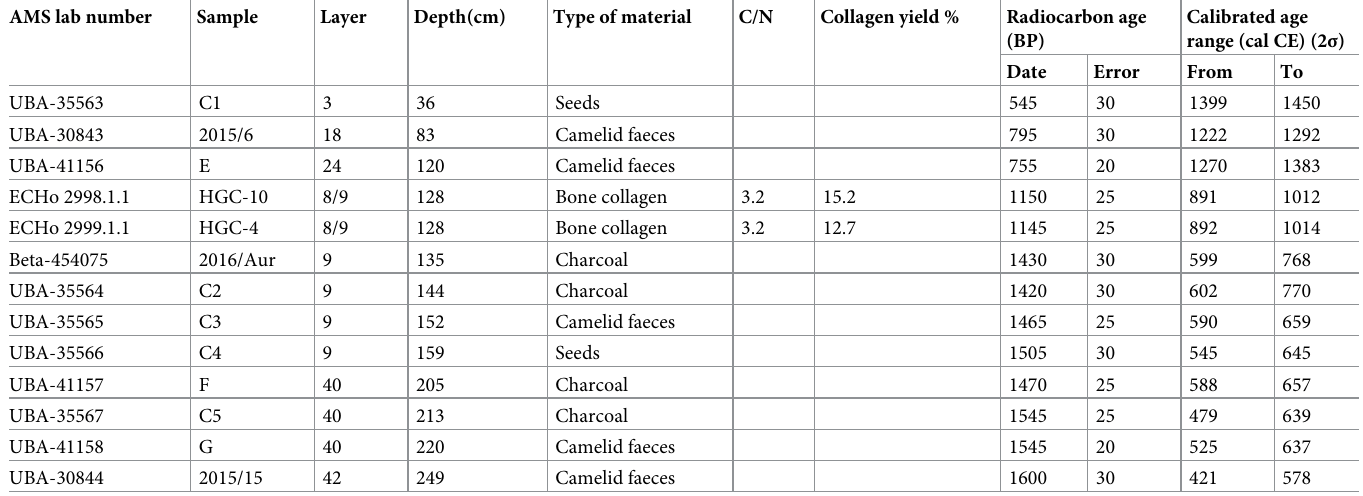
Table 2. Radiocarbon sample details and